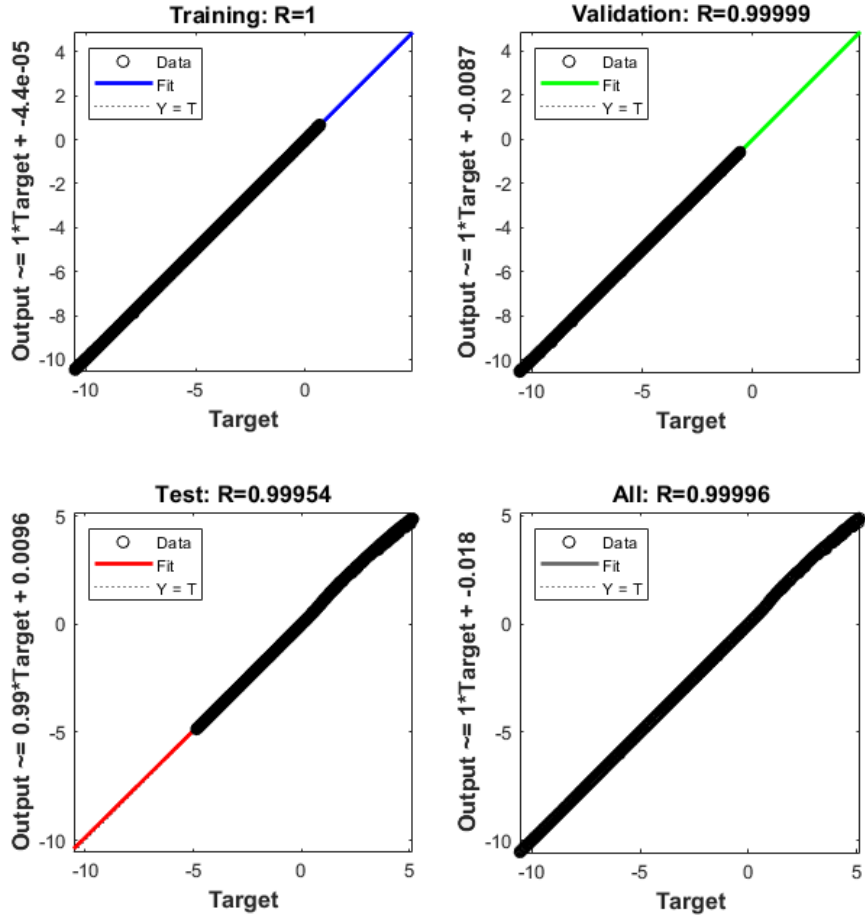
Figure 39. Regression in neural model identification.